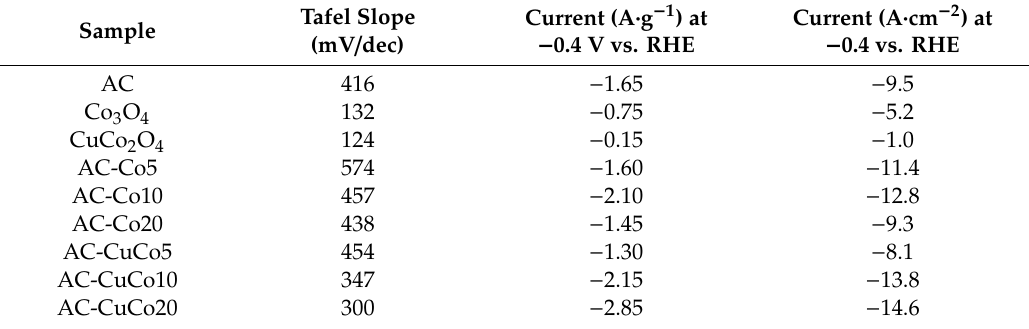
Table 4. Electrochemical parameters of the di ff erent materials tested in the hydrogen evolution reaction.